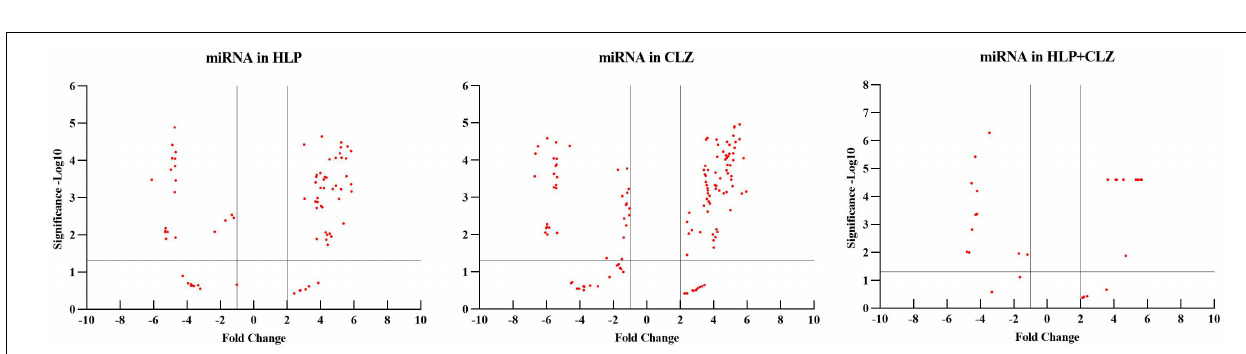
Frontiers in Molecular Neuroscience |